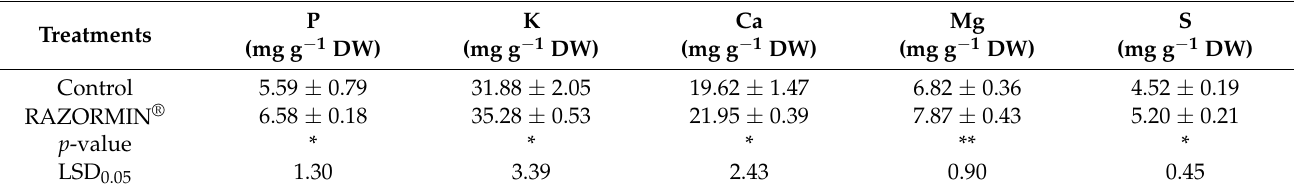
Table 5. Effect of the biostimulant RAZORMIN ® application on the foliar content of